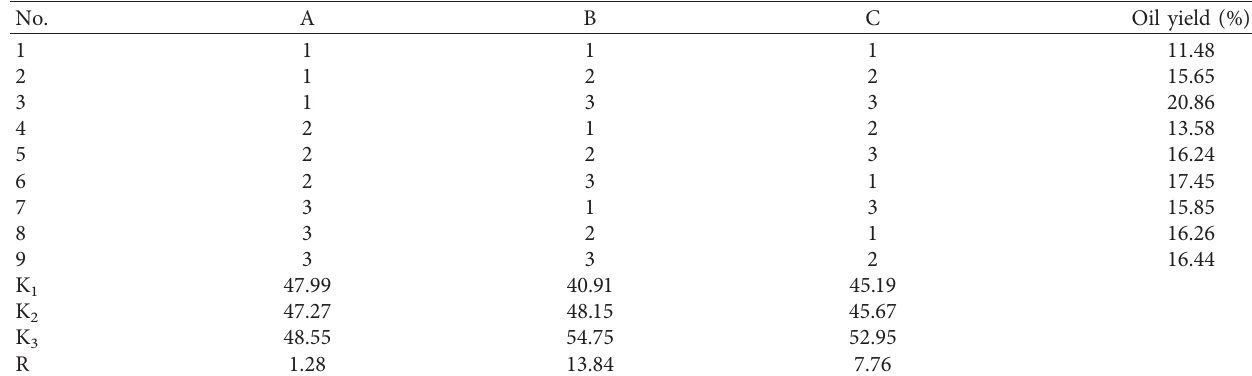
Table 2: Orthogonal experimental design and results of oil flash extraction from palm seed.